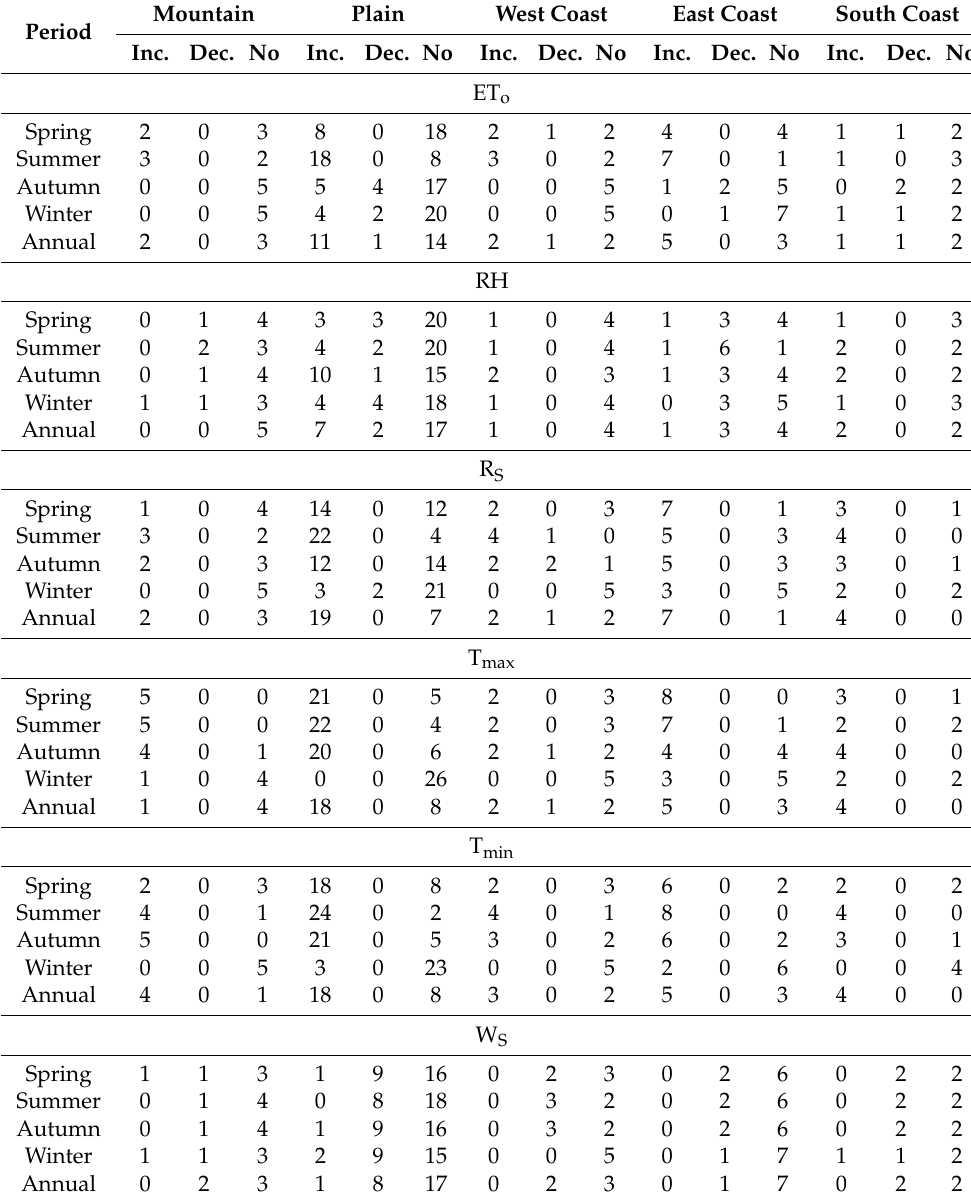
Table 5. Identification of the significant increasing, decreasing, and non-significant trends of ET o and meteorological variables on seasonal and annual